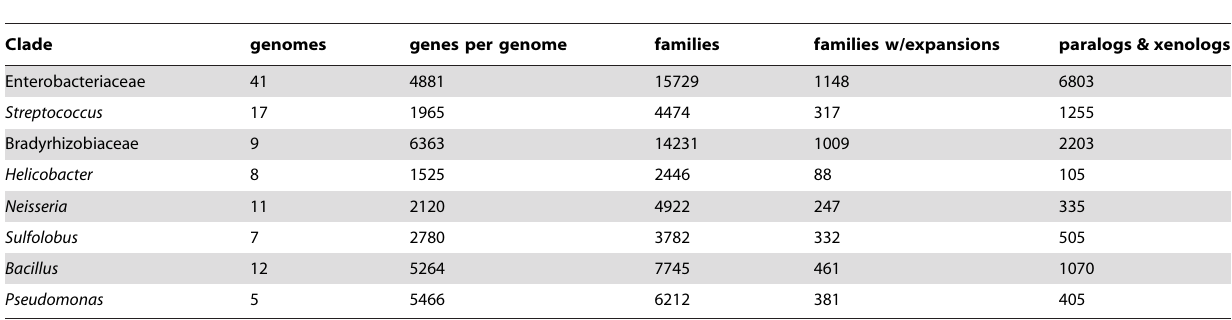
Table 1. Expansions of gene